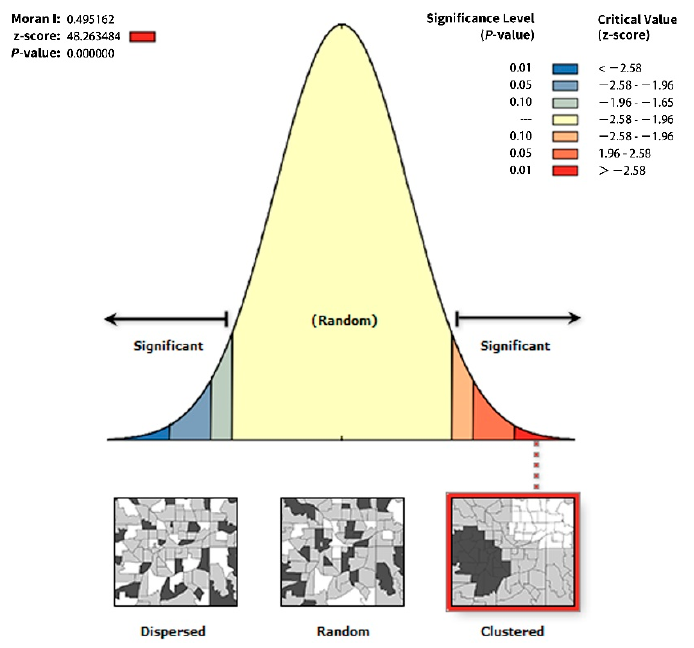
Figure 3. Space autocorrelation report of benchmark rent. Table 4. LM statistics test results of the housing rent space weight